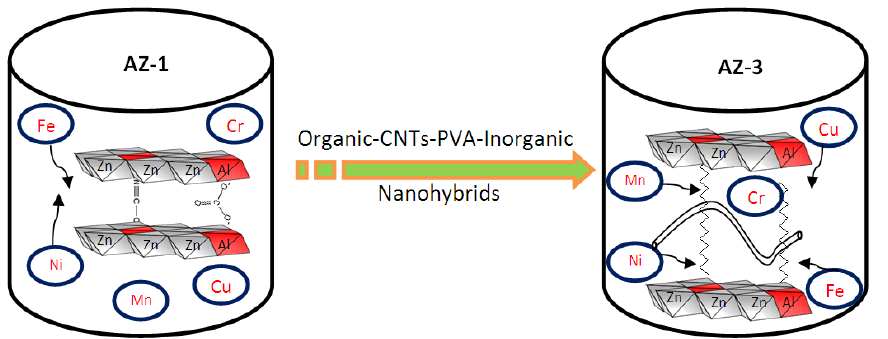
Figure 11. The removal process of heavy metals from water in an extremely acidic medium for the AZ-3